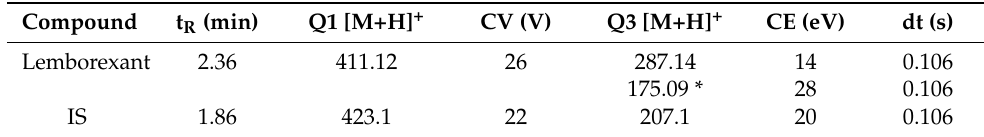
Table 2. Gradient condition of mobile phase used for sample